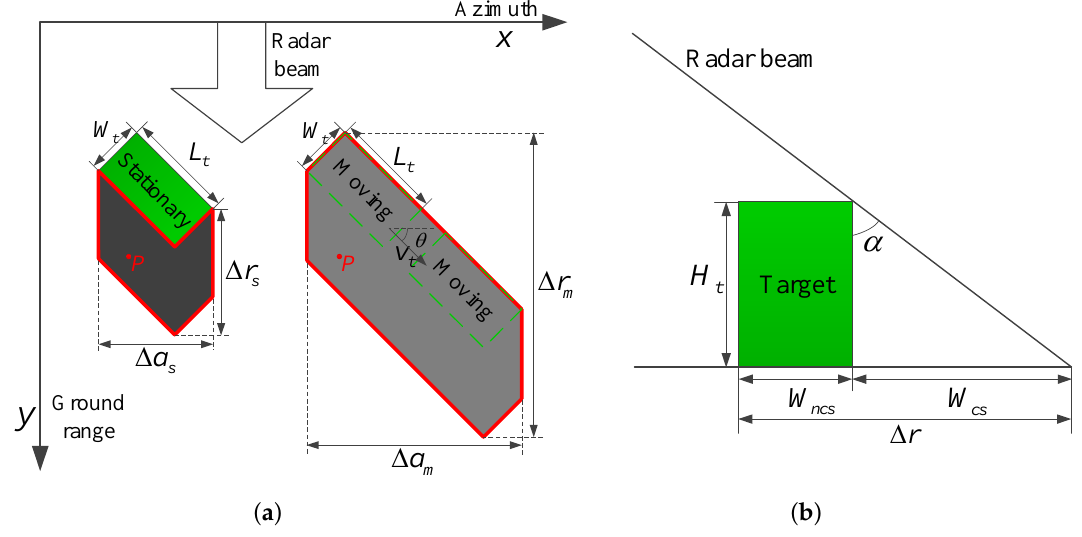
Figure 2. Formation of shadow in VideoSAR images. ( a ) Description of top view (the defocusing energy of moving target is omitted). ( b ) Description of side